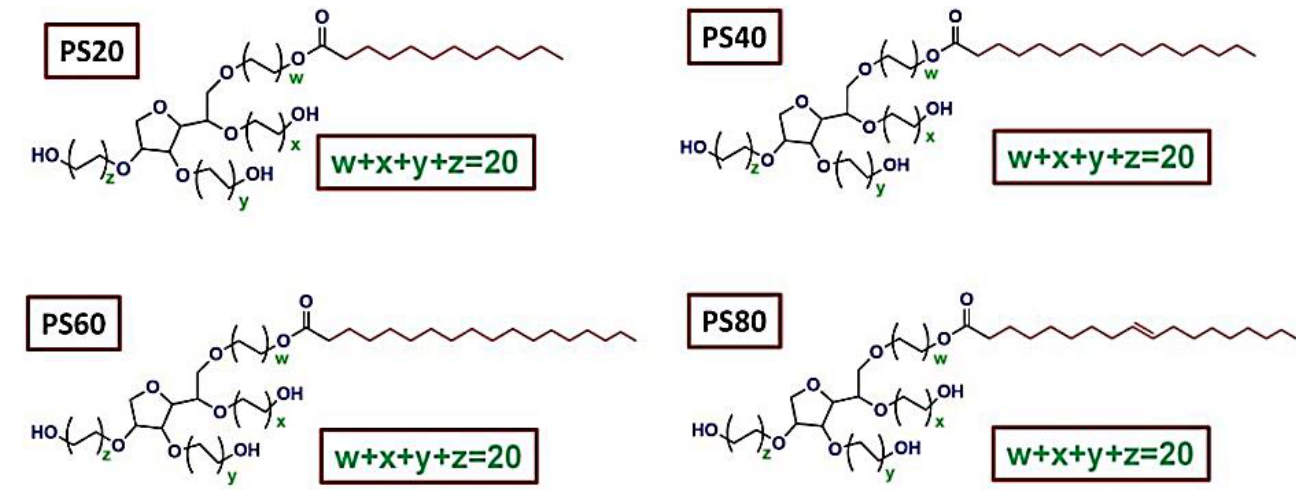
Figure 3. Structures of several PSs, adapted from [76] , MDPI, 2021.